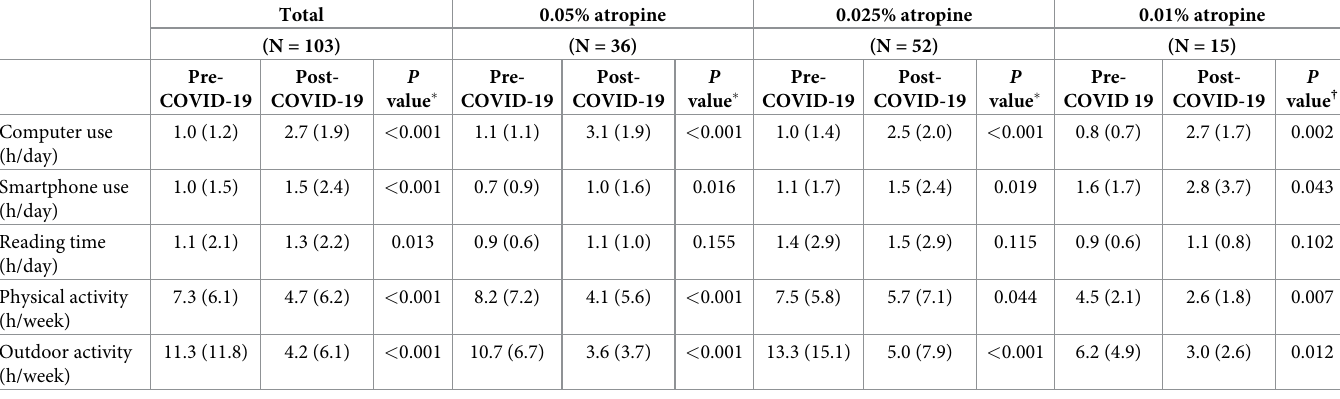
Table 4. Questionnaire in the 0.05% atropine, 0.025% atropine, and 0.01% atropine